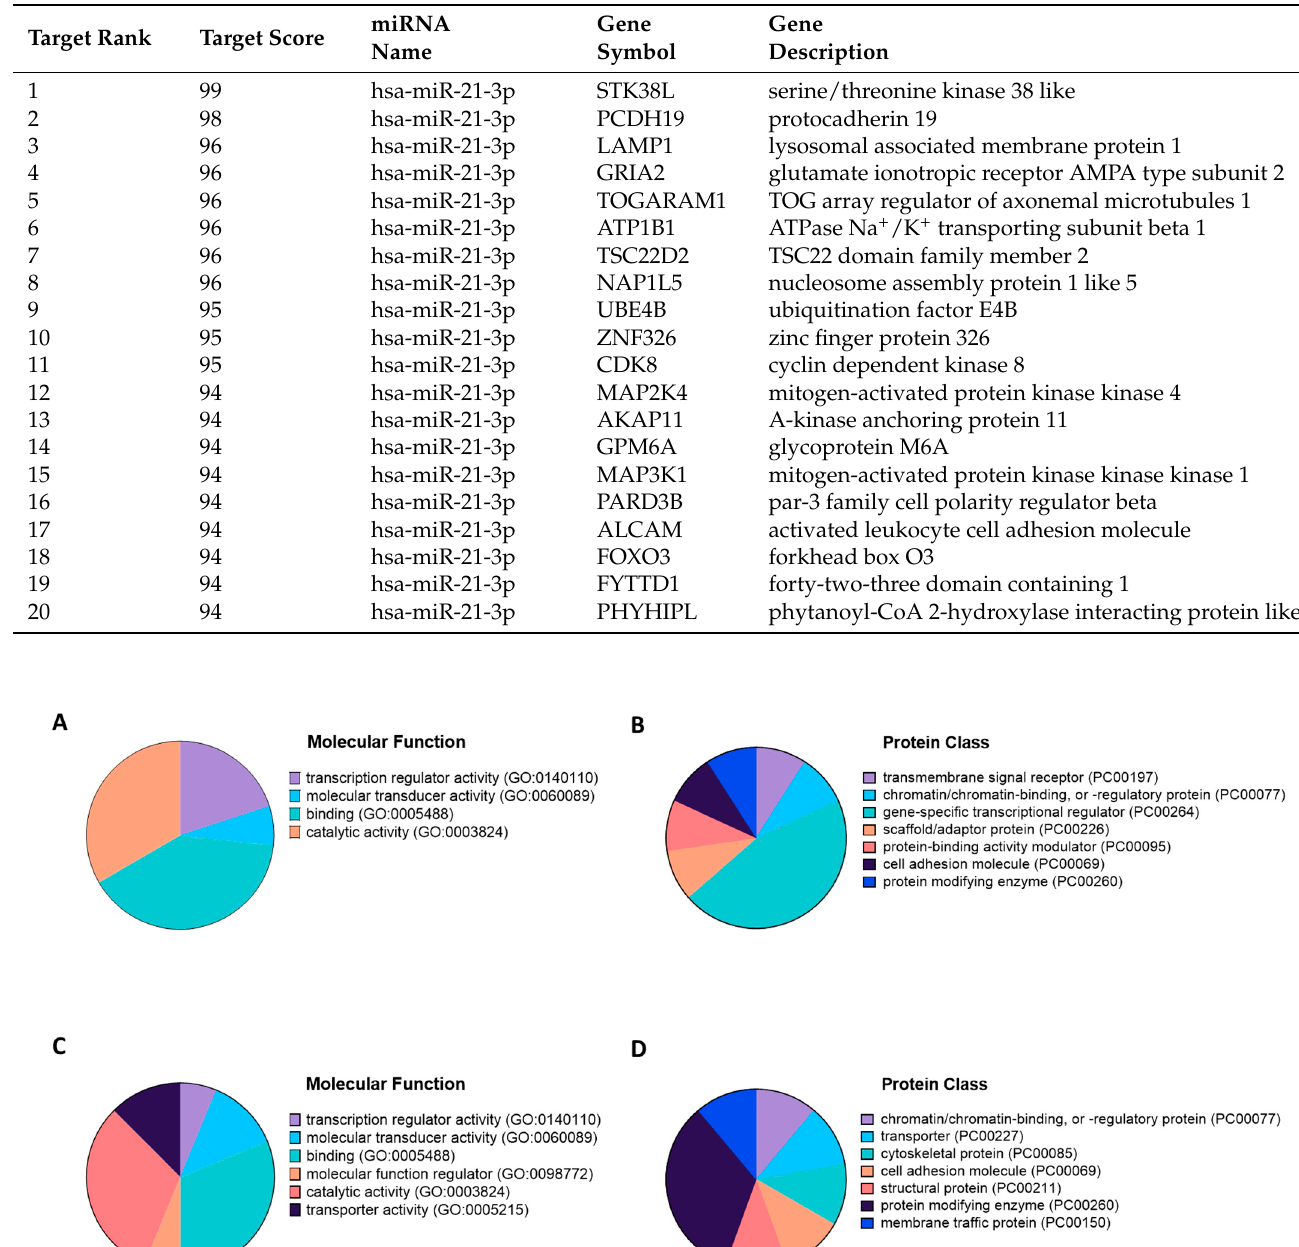
Table 3. Top 20 gene targets of hsa-miR-21-3p. Identification of the predicted targets of hsa-miR-21-3p with a prediction score >94 using miRDB.